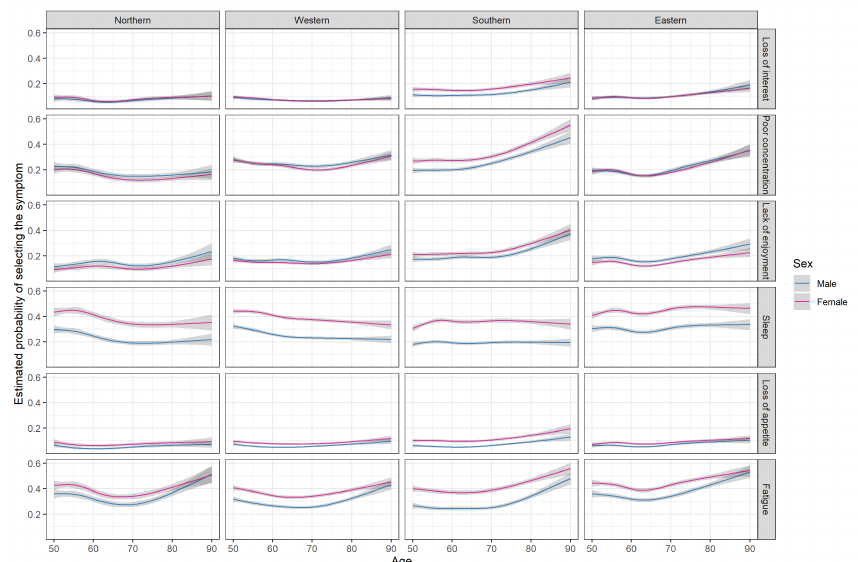
Figure 5. Estimated probability of selecting a symptom (motivation and somatic). Estimates were obtained from logistic regression models including two-way interactions between age, sex and region (base model) and additional risk factors (education, BMI, current smoking, presence of chronic disease, vigorous physical activity, living arrangement; adjusted model); age was modelled using restricted cubic splines (rcs). See Table 3 for sample sizes within each region and by sex, and for descriptive